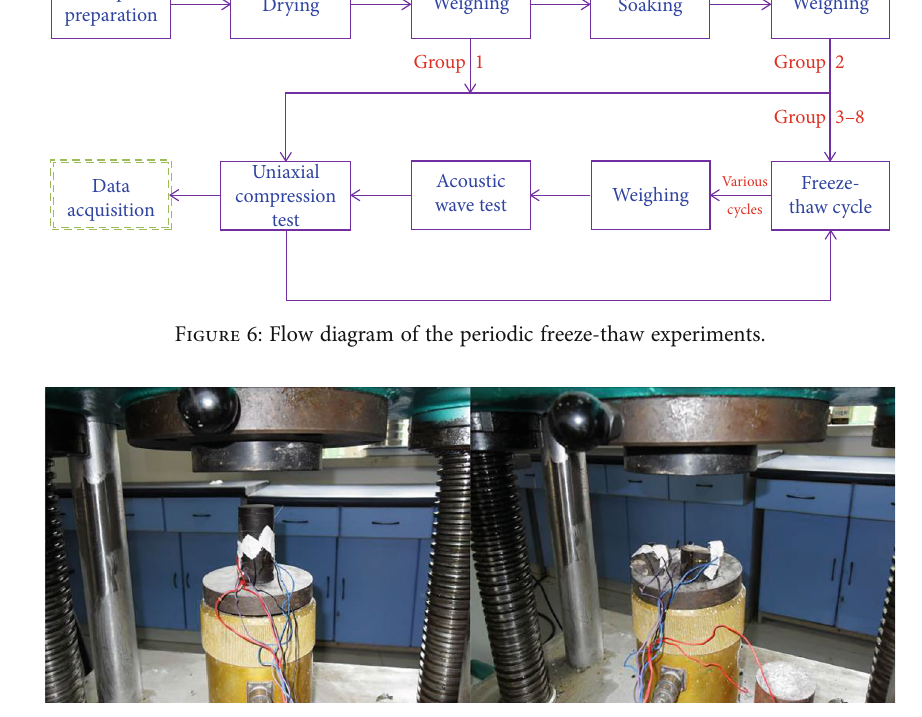
Figure 7: Test on the mechanical properties of the measured oil shale samples.